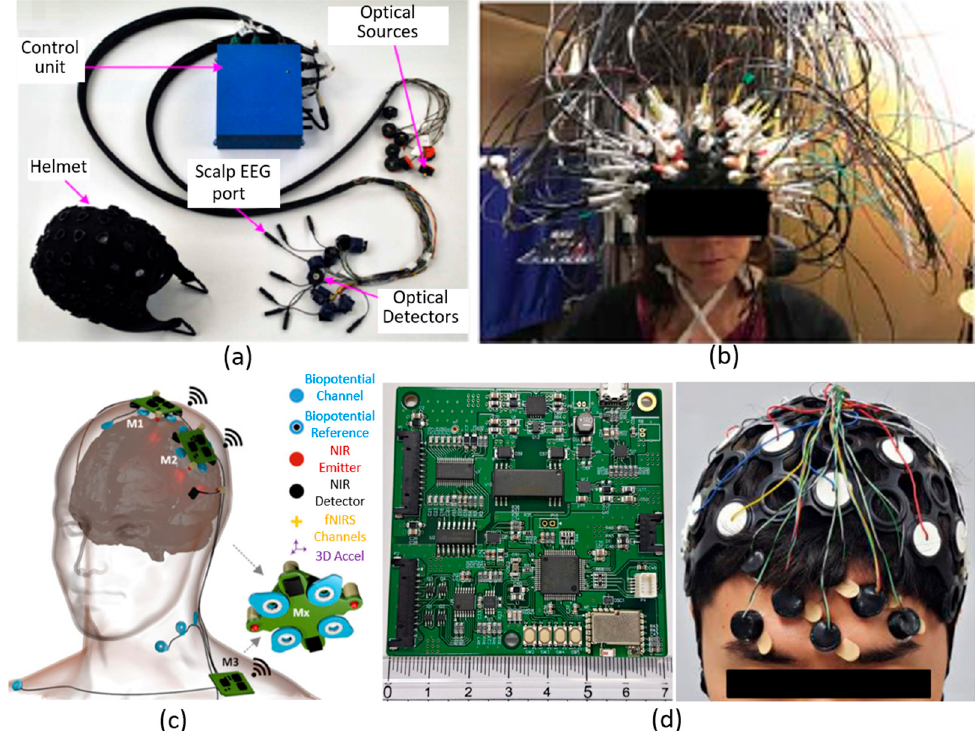
Figure 1. Examples of discrete components-based, integrated EEG–fNIRS systems. ( a ) The wireless, integrated EEG–fNIRS system described by Sawan et al. It consists of a helmet to house the front-end optical and electrical components, a distant control unit for system control and data transmission, and cabling. This figure was taken and modified with permission from [39]. ( b ) The system with 128 fNIRS channels (32 sources, 32 detectors) and 32 EEG channels described by Kassab et al. Extensive cabling was utilised in this multichannel system. This figure was taken with permission from [42]. ( c ) The modular, integrated EEG–fNIRS system described by von Luhmann et al. It is comprised of three individual modules, producing 13 fNIRS and 8 EEG channels. This figure was taken with permission from [40]. ( d ) The dry electrode-based, integrated EEG–fNIRS system described by Lee et al., consisting of a cap to position eight optodes (2 sources and 6 detectors), two custom-designed control boards, and cabling. This figure was taken with permission from [43].